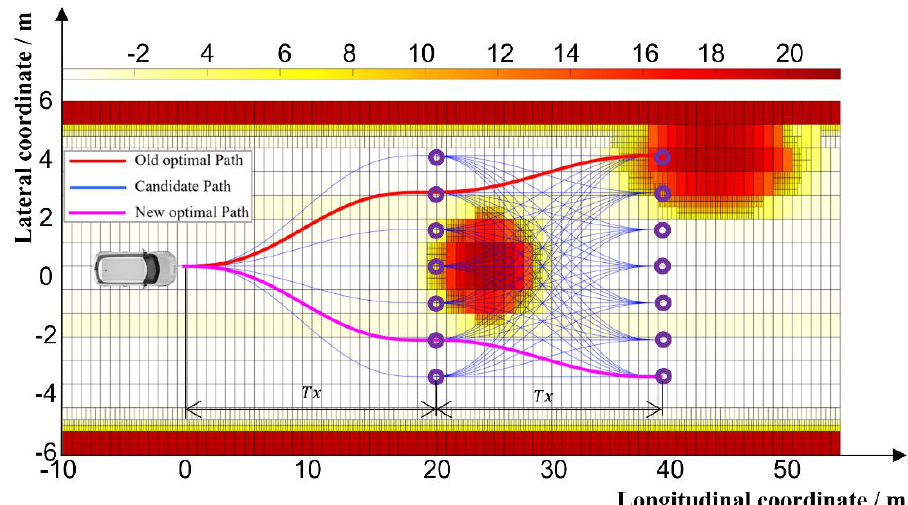
Figure 16. Path cluster generation for actual vehicle scenario.